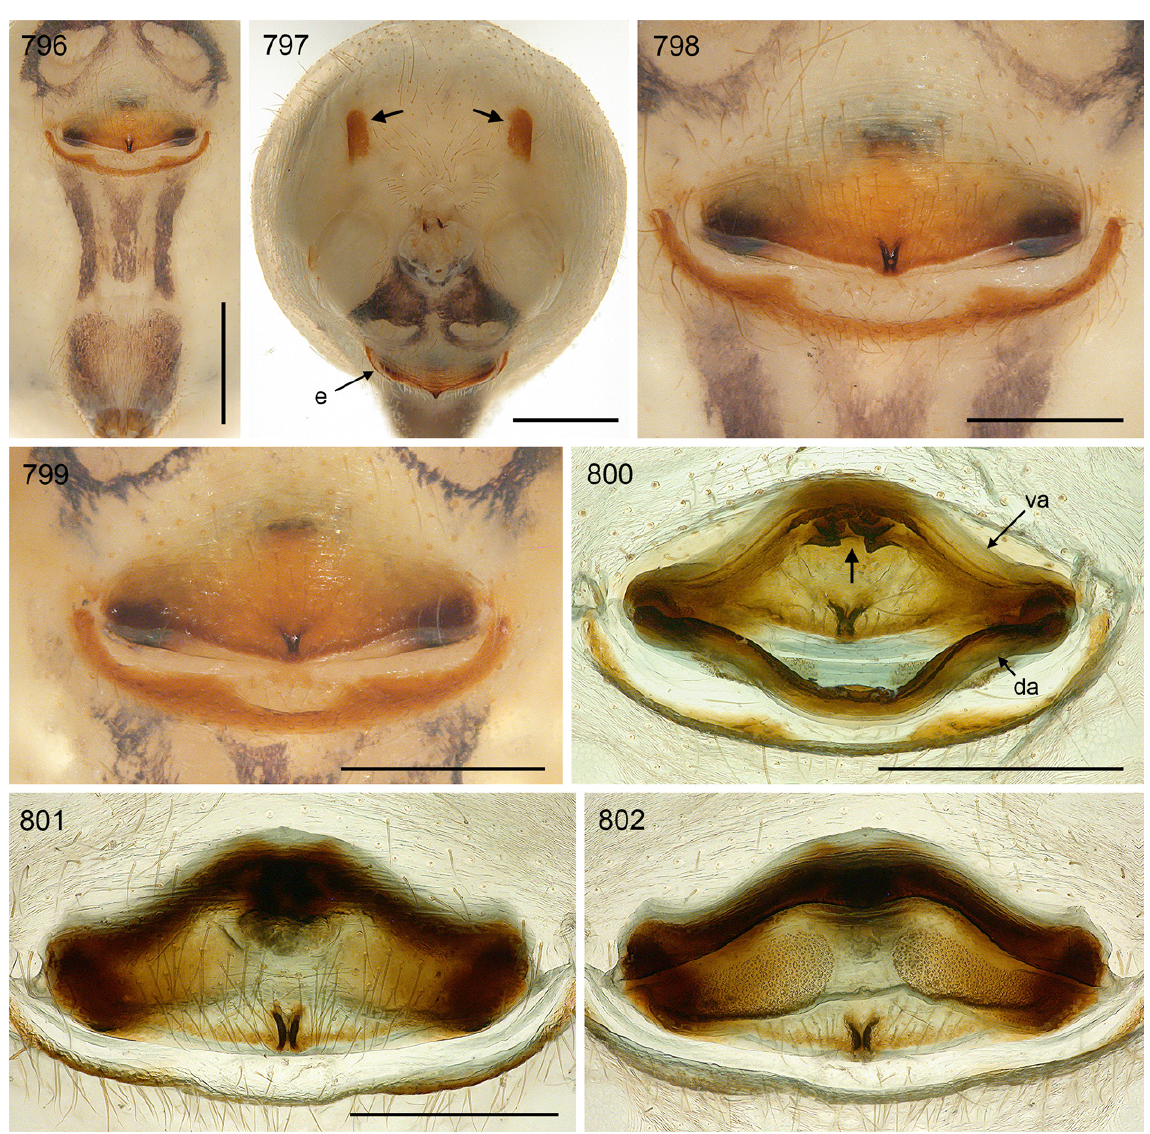
Figs 796–802. Crossopriza lyoni (Blackwall, 1867); females from Japan, Yamamoto-chô (796–798, 801–802; ZFMK Ar 5209) and from Guinea, Kindia (799–800; ZFMK Ar 10456, see Huber & Kwapong 2013). 796–797 . Abdomen, ventral and frontal views; arrows: stridulatory plates. 798–799 . Epigyna, ventral views. 800–802 . Cleared female genitalia, dorsal view with dorsal arc tilted backwards, ventral view, and regular dorsal view; arrow: asymmetric median sclerite. Abbreviations: da = dorsal arc; e = epigynum; va = ventral arc. Scale bars: 796–797 = 1.0 mm; 798–802 = 0.5